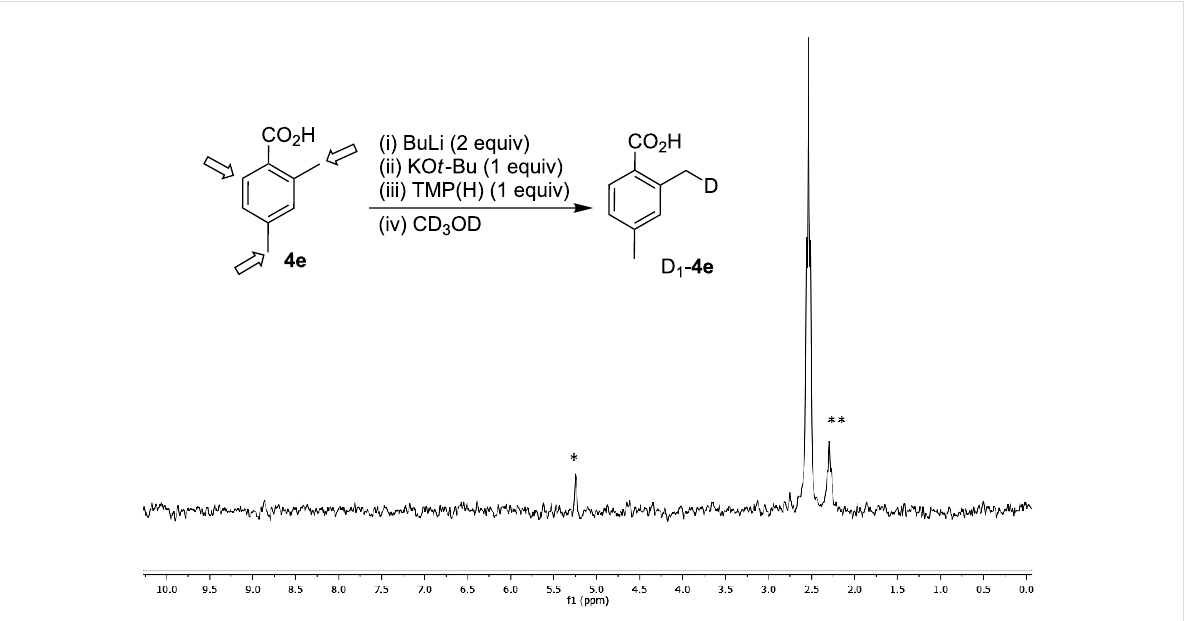
Figure 2: Metalation selectivity for 4e (arrows indicate potential metalation sites) . 2 H NMR spectrum in CH 2 Cl 2 . *CD 2 Cl 2 . **2-Methyl-4-D-methylben- zoic acid.